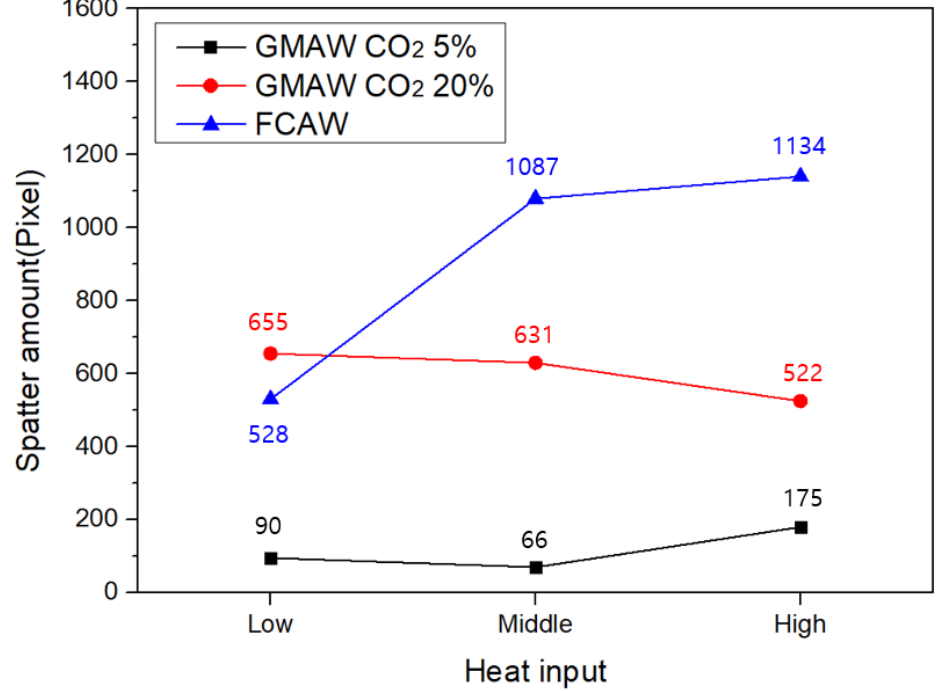
Figure 20. Results of image-processed welding spatter.